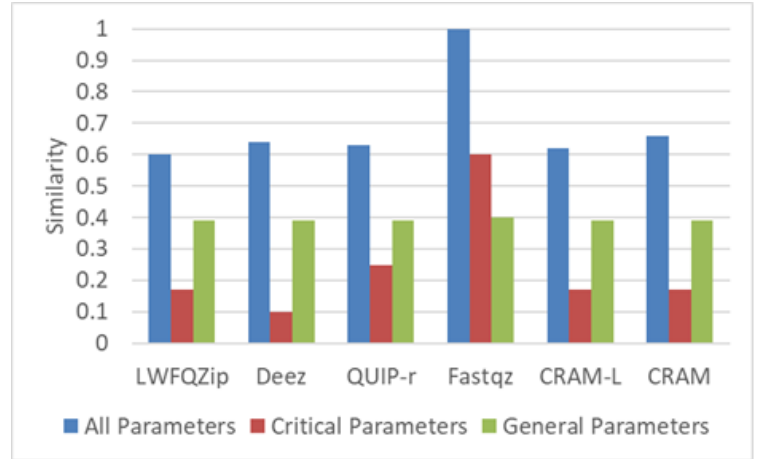
Figure 7. Similarity and weighting results of NGS referential algorithms.